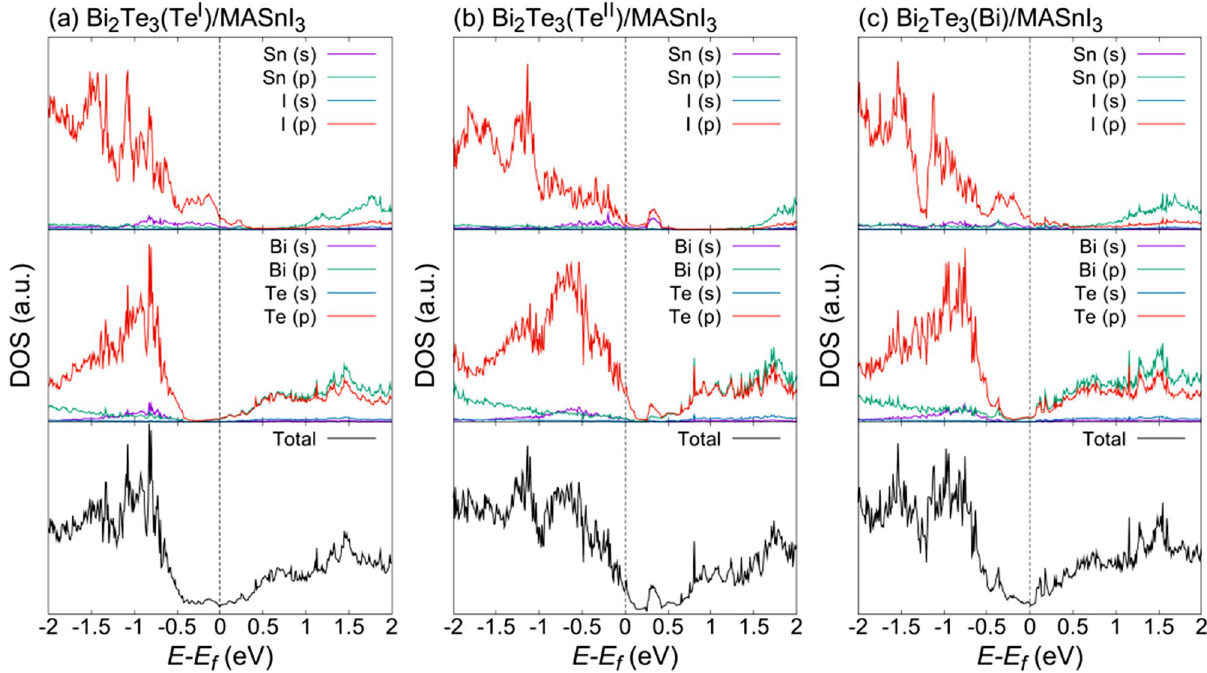
Figure 3. Total and partial DOS around the Fermi energy of ( a ) Bi 2 Te 3 (Te I )/MASnI 3 , ( b ) Bi 2 Te 3 (Te II )/MASnI 3 , and ( c ) Bi 2 Te 3 (Bi)/MASnI 3